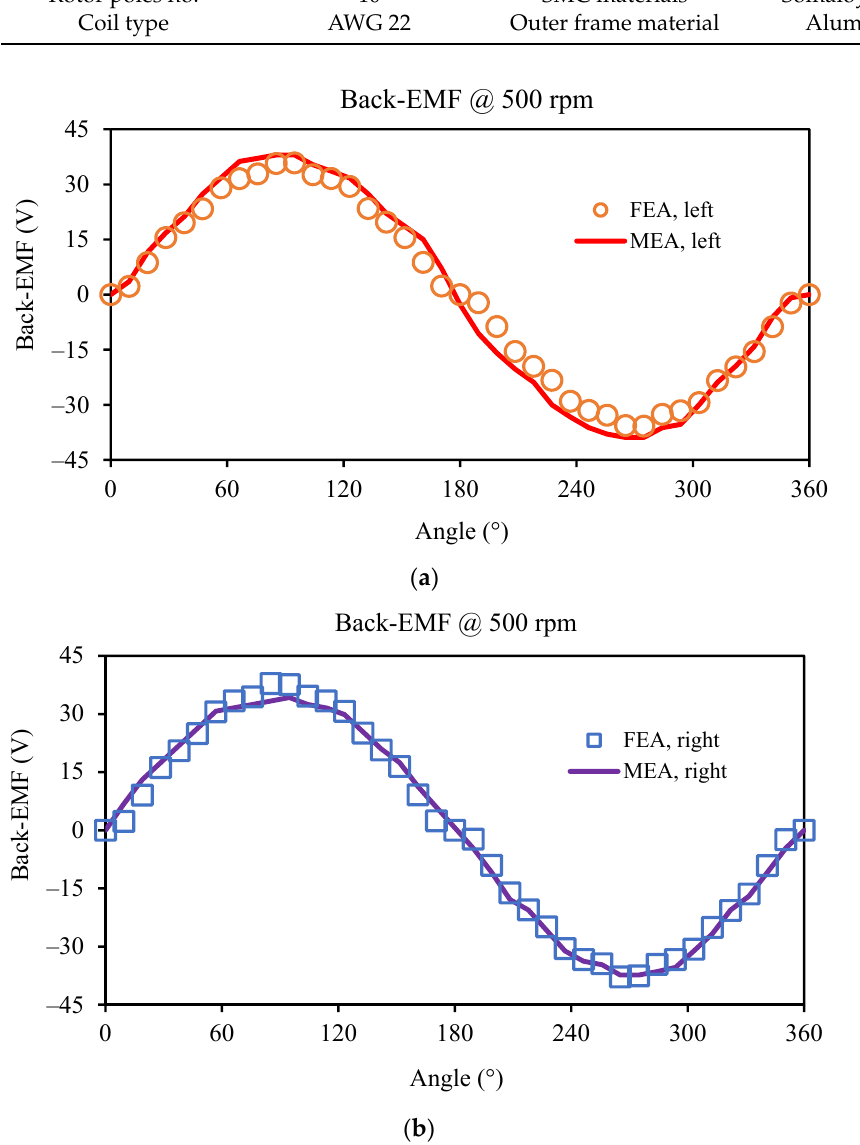
Figure 10. No-load back-EMFs without MC current: ( a ) left rotor; ( b ) right rotor.